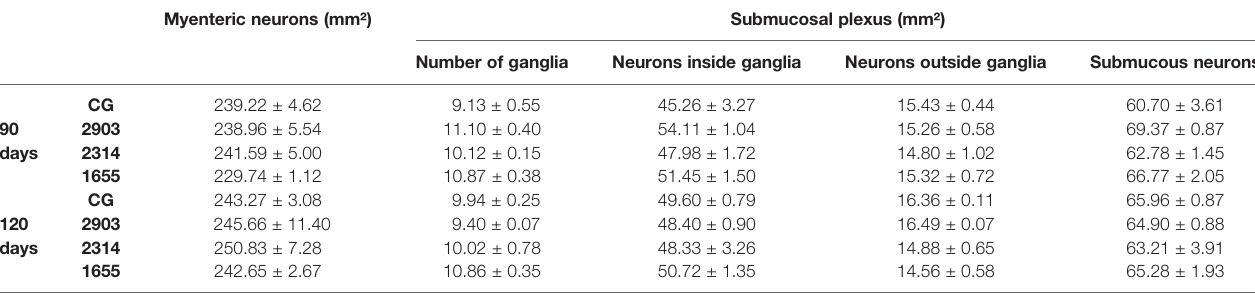
The data are expressed as mean ± SE in 1 mm 2 (n= 4). GC, control group. 2903, group infected with MHOM/BR/1975/M2903. 2314, group infected with MHOM/BR/2003/2314. 1655, groupinfectedwithMHOM/BR/2000/1655. Numberofneurontotalswerecountedinthemyenteric plexus.Numberofganglia,thequantity ofneuronsinsideandoutsidetheganglia,and the total number of neurons in the plexus were counted in the submucosal